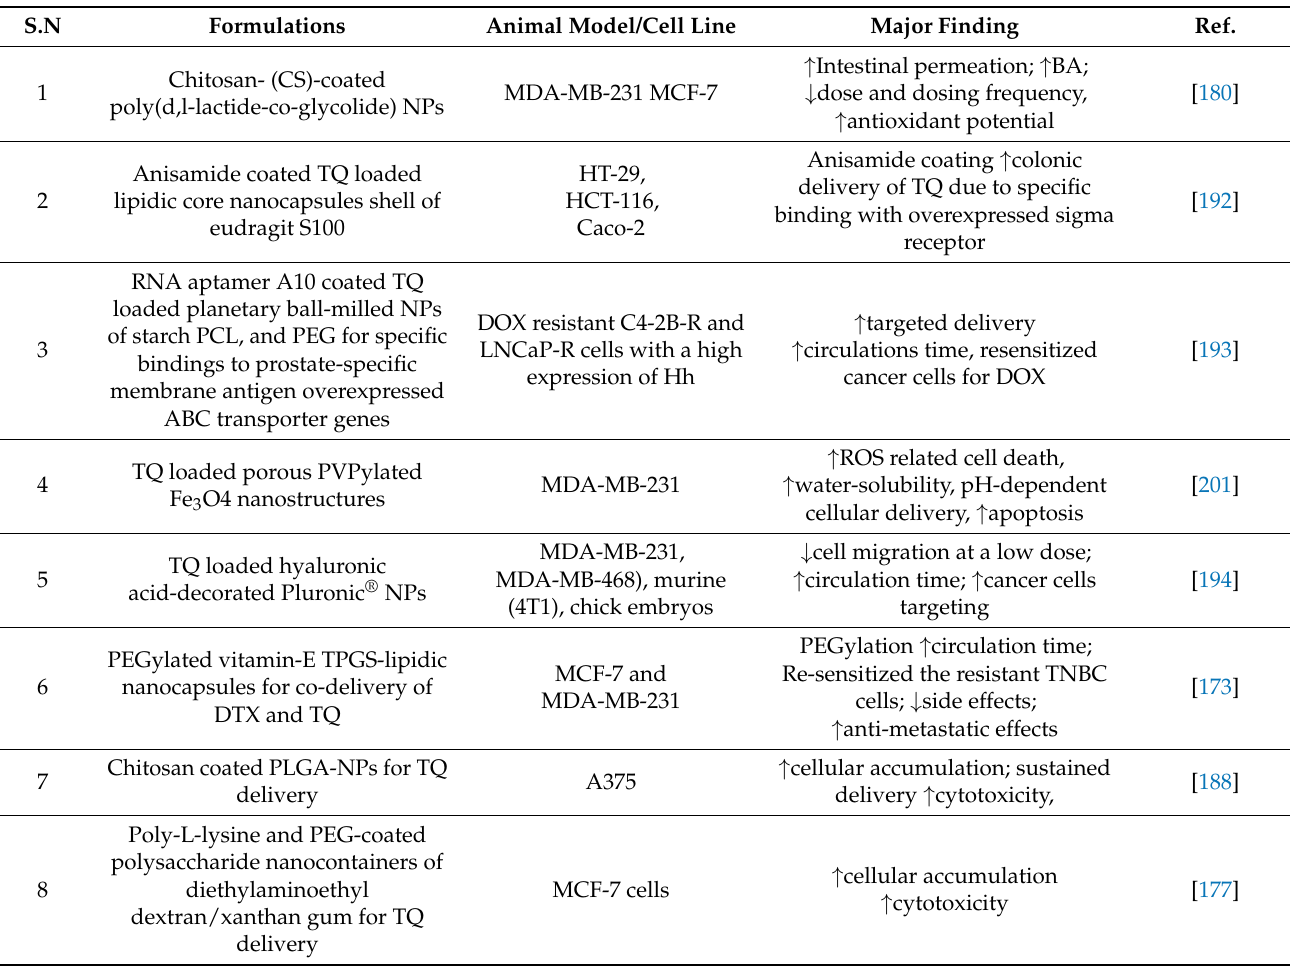
Table 6. Surface-modified TQ nanocarrier in the management of cancer ( ↓ : decrease, ↑ : increase).